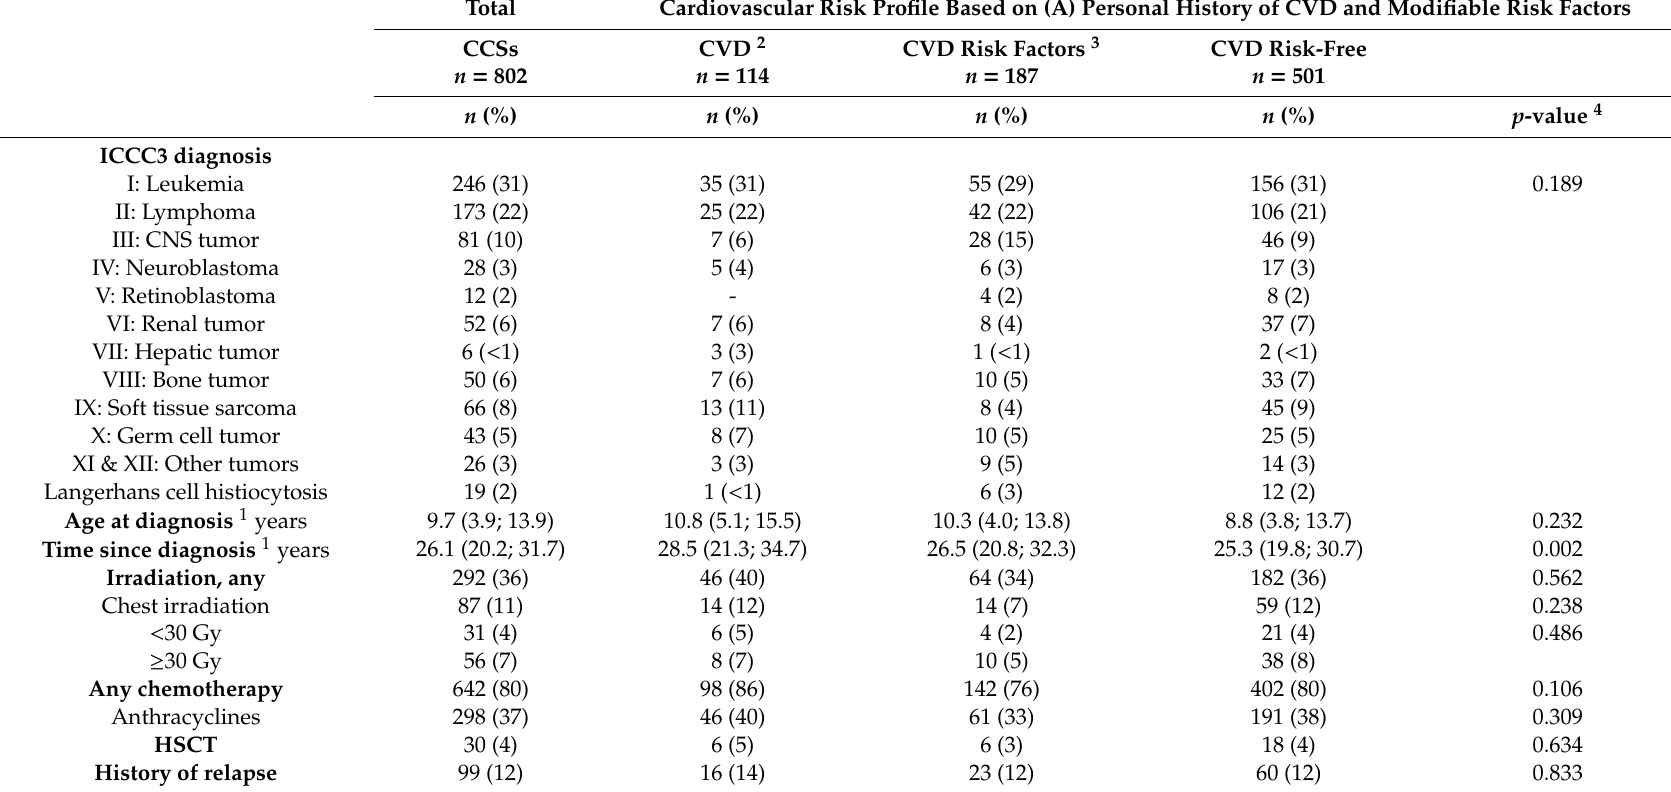
Table 2. Clinical characteristics of adult childhood cancer survivors (CCSs) by cardiovascular risk profile